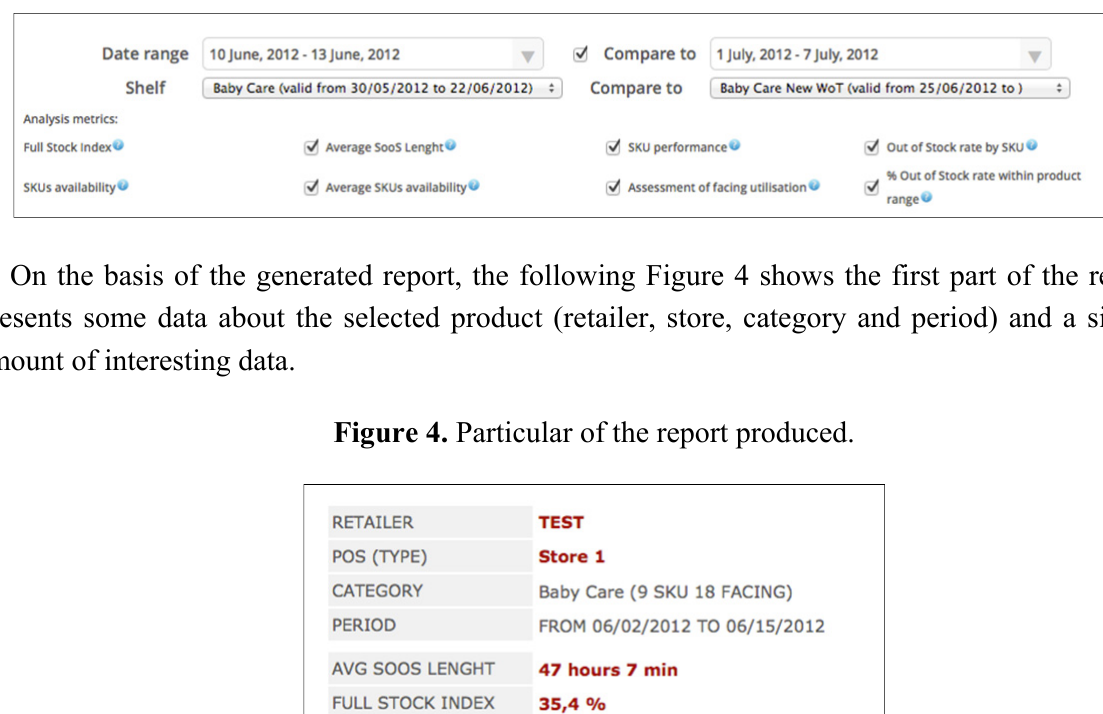
Figure 3. Example of report with a product of interest.